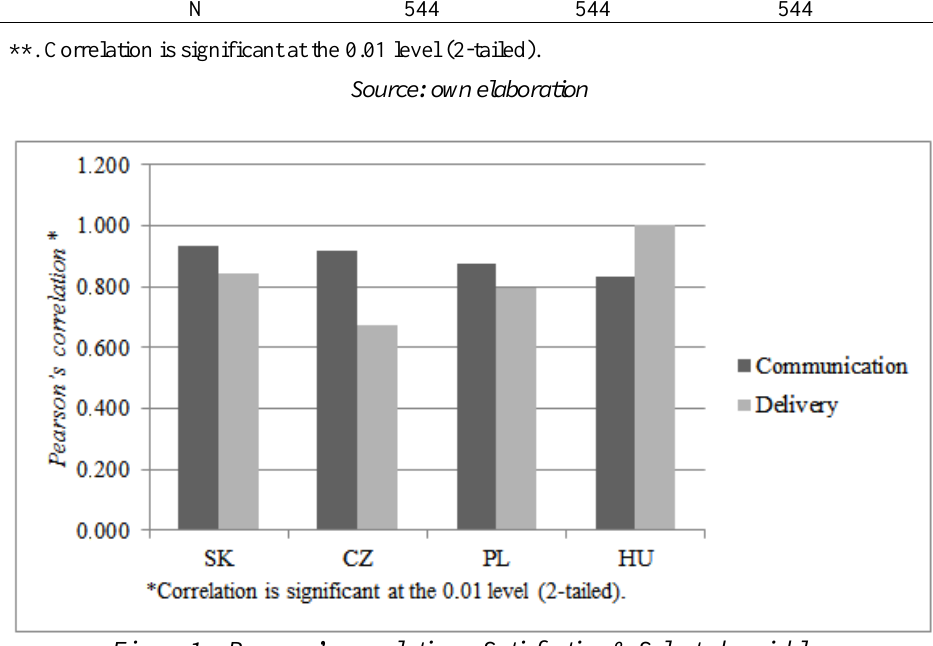
Figure 1 – Pearson’s correlation – Satisfaction & Selected variables Source: own